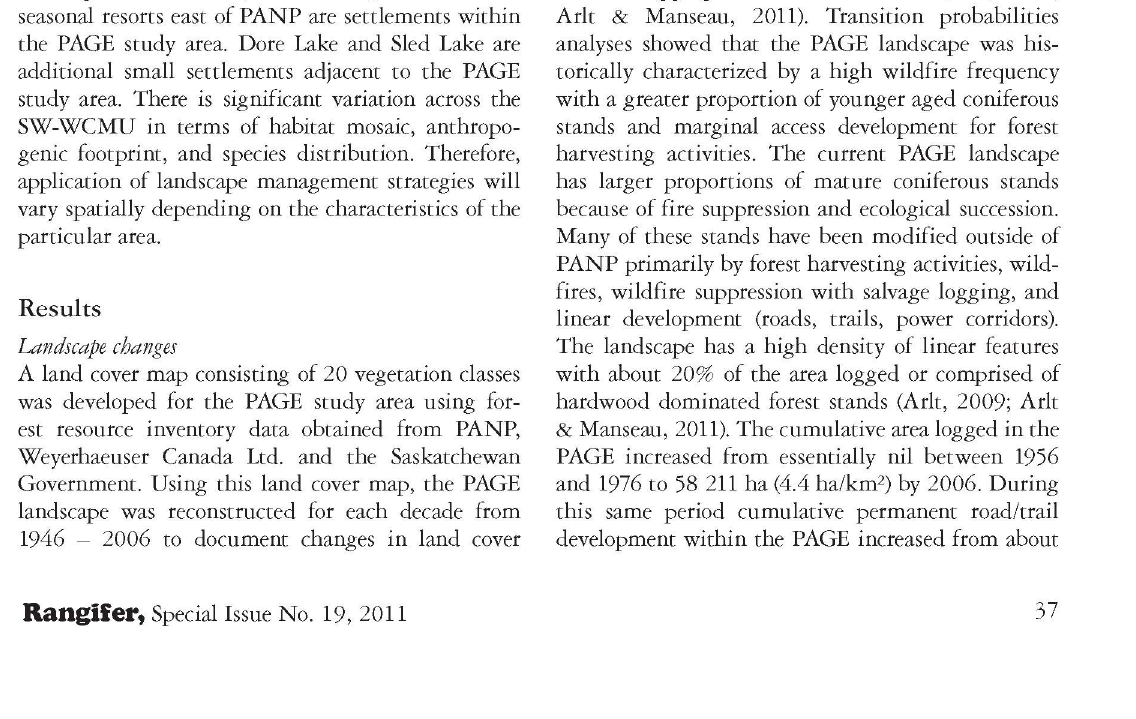
Fig. 2. Map of the Prince Albert Greater Ecosystem highlighting anthro pogenic features and telemetry data from 28 female caribou between